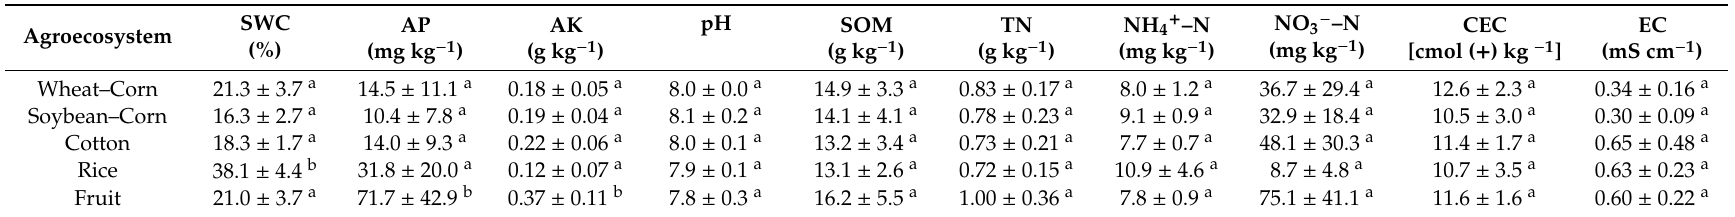
Table 2. The properties of soil in the corn and wheat rotation (Corn–Wheat), fruits (Fruit), rice, soybean and corn rotation (Soybean–Corn), and cotton agroecosystems used in this study. SWC, soil water content; AP, available phosphorous; AK, available potassium; pH; SOM, organic matter; TN, total nitrogen; NH 4 + –N, ammonium; NO 3 − –N, nitrate; CEC, cation exchange capacity; and EC, electrical conductivity.